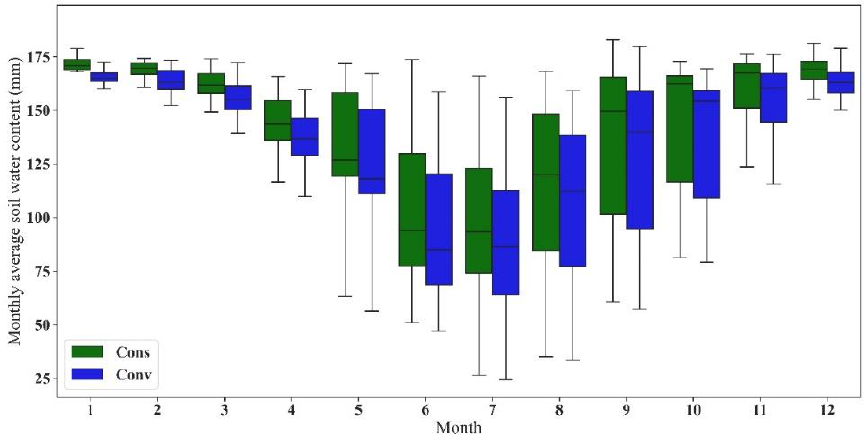
Figure 7. Average soil water content (mm) by month across the modeled time period in Vrchlice.